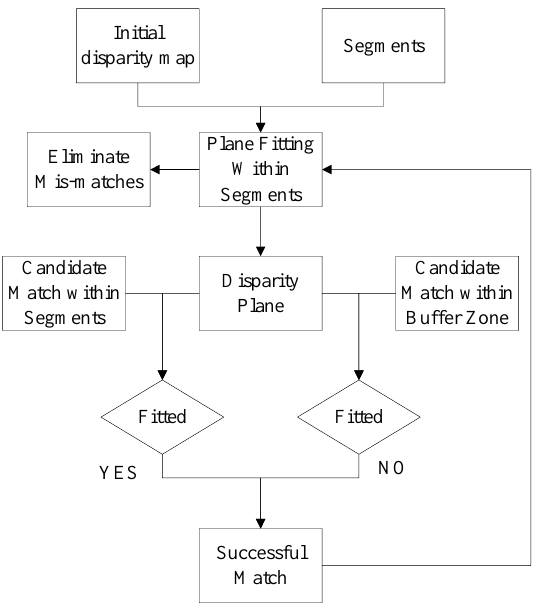
Fig.5 The flowchart of the occlusion